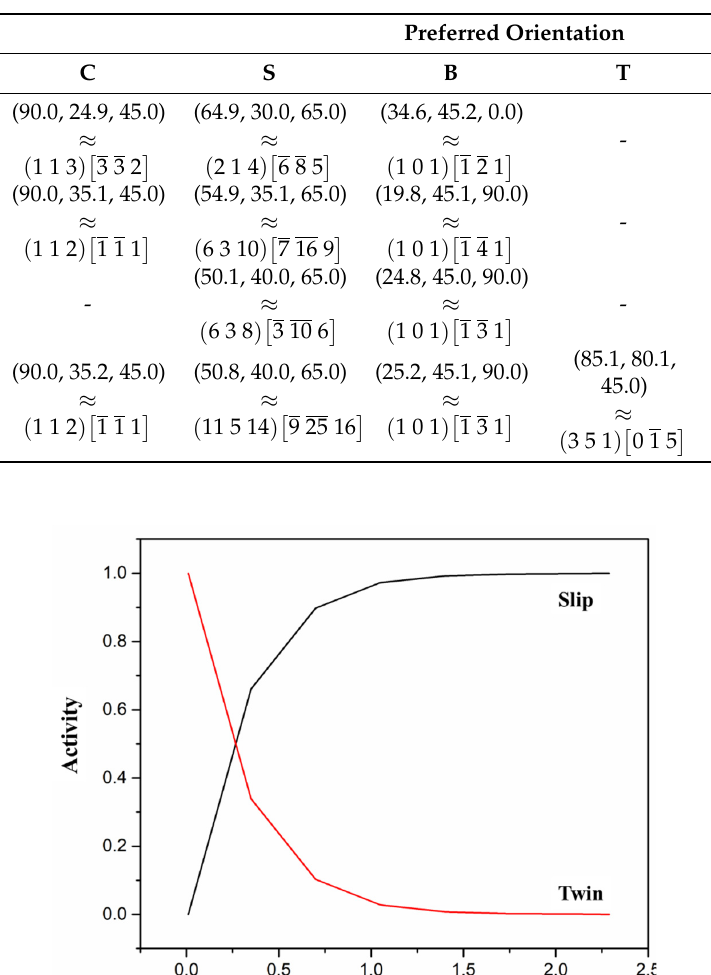
Table 2. Major orientation components predicted with random orientations using FC-, RC-, MT-, and MTCS-models after 90% reduction.